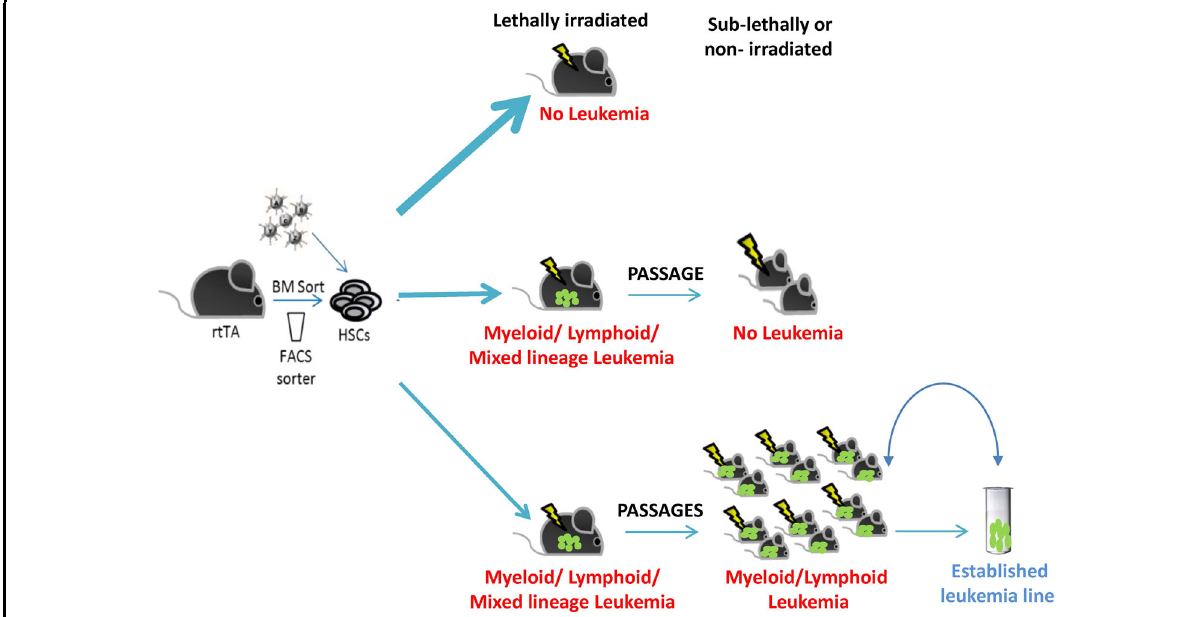
Fig. 7 Generation of a multiple leukemia line in vivo. Schematic model demonstrating that overexpression of a mix of oncogenes in immunocompetent mice can induce malignant leukemia. Upper arrow: no leukemia develops. Middle arrow: initial growth suspected but no further passage. Lower arrow: leukemia is generated and passaged. Established leukemia-lines can easily transfer such